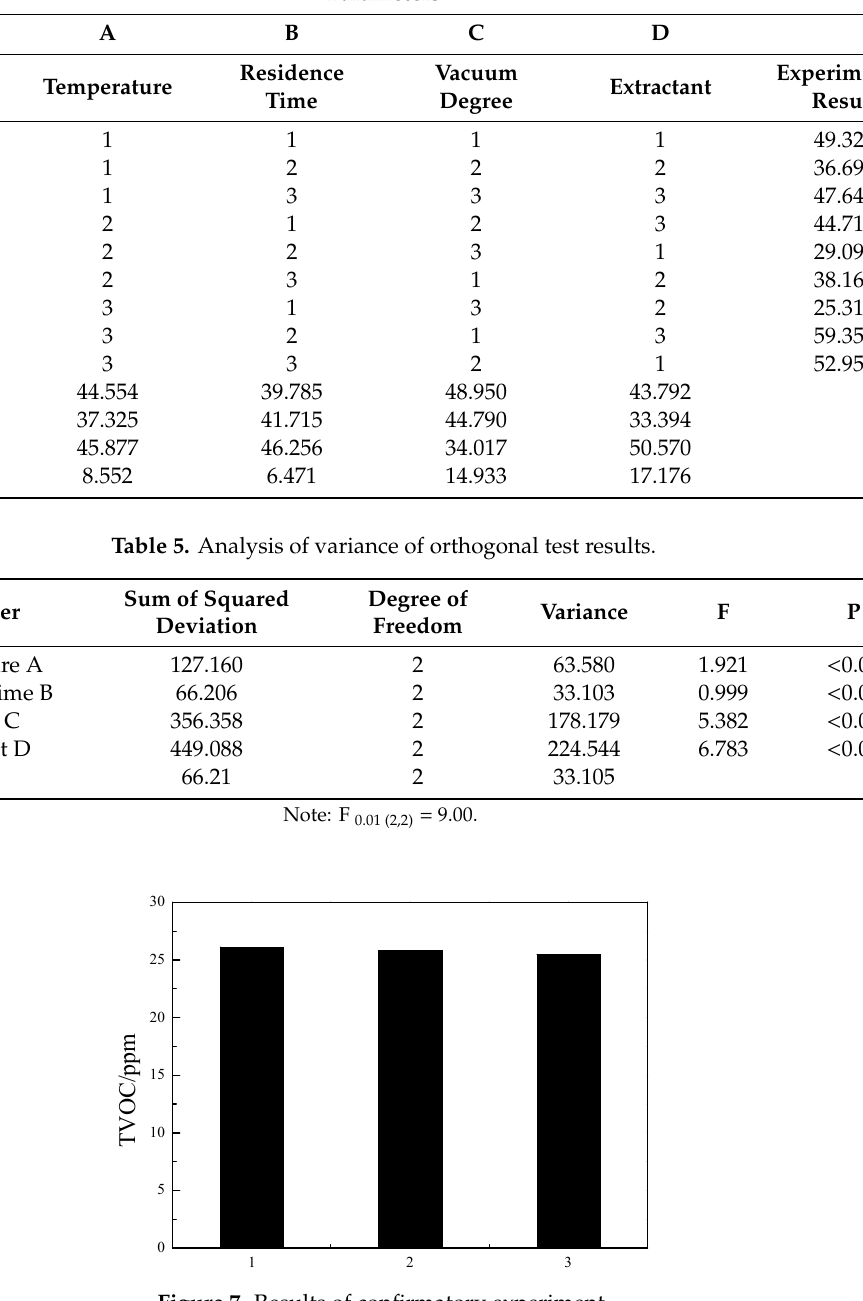
Figure 7. Results of confirmatory experiment.